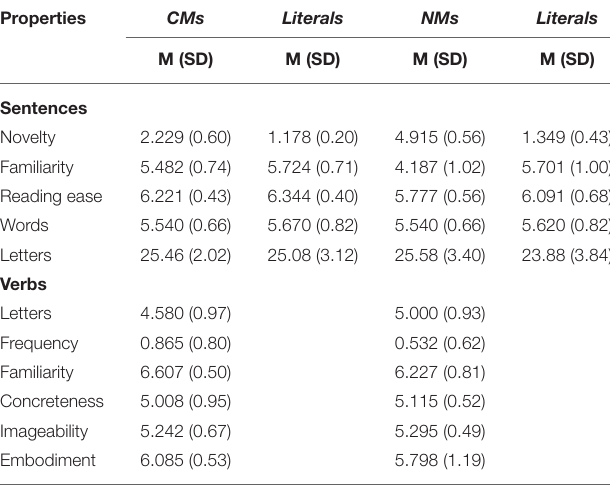
TABLE 3 | Percentage of concept agreement, mean visual complexity and